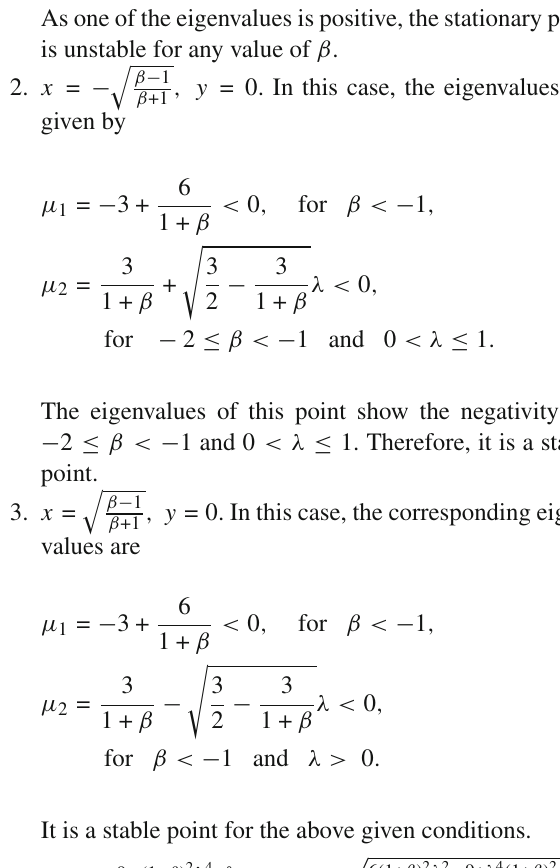
of w φ and (cid:3) φ . For this point, we consider two cases: (a) β = − 2 . 5 and 1 ≤ λ < 1 . 5, in which Case (4)